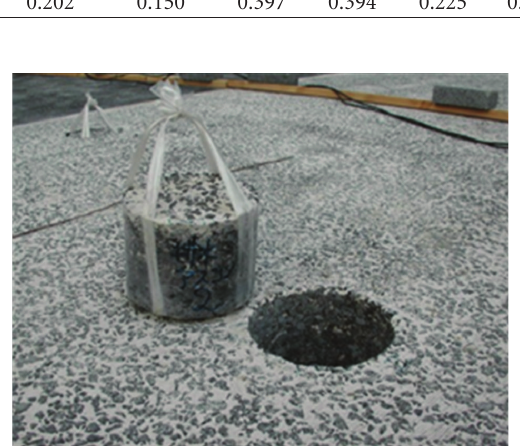
Figure 6: Core for recording the weight (15cm diameter).